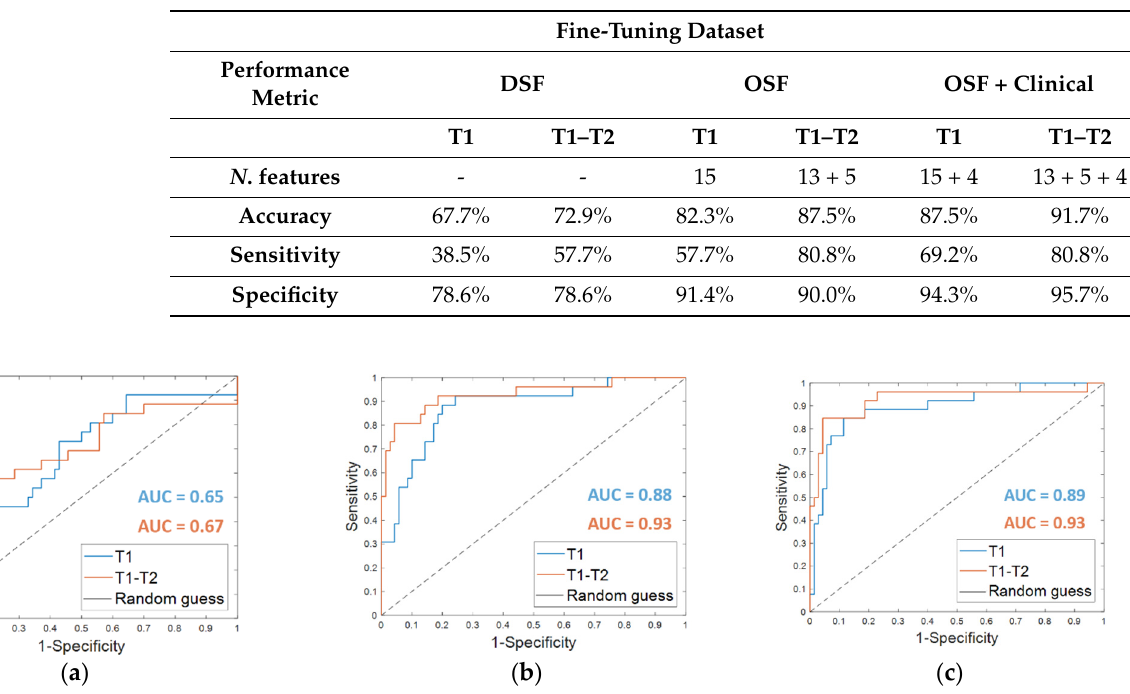
Figure 3. ROC curves for breast cancer recurrence prediction models on the fine-tuning dataset ( a ) using the Dynamically Selected Features, ( b ) the Optimal Subset of Features alone and ( c ) combined with the clinical features, respectively. The AUC values are also highlighted. Table 2. Summary of the performances of the breast cancer recurrence prediction models on the fine-tuning dataset in terms of accuracy, sensitivity, and specificity, using the Dynamically Selected Features (DSF), the Optimal Subset of Features (OSF), also combined with the clinical features (OSF + clinical), respectively. The features were selected for the exams at timepoint T1 alone or at timepoints T1–T2 simultaneously (original model). The numbers of features selected for OSF and OSF + clinical are also highlighted. The numbers of DSF features are omitted because they vary from one patient to another.